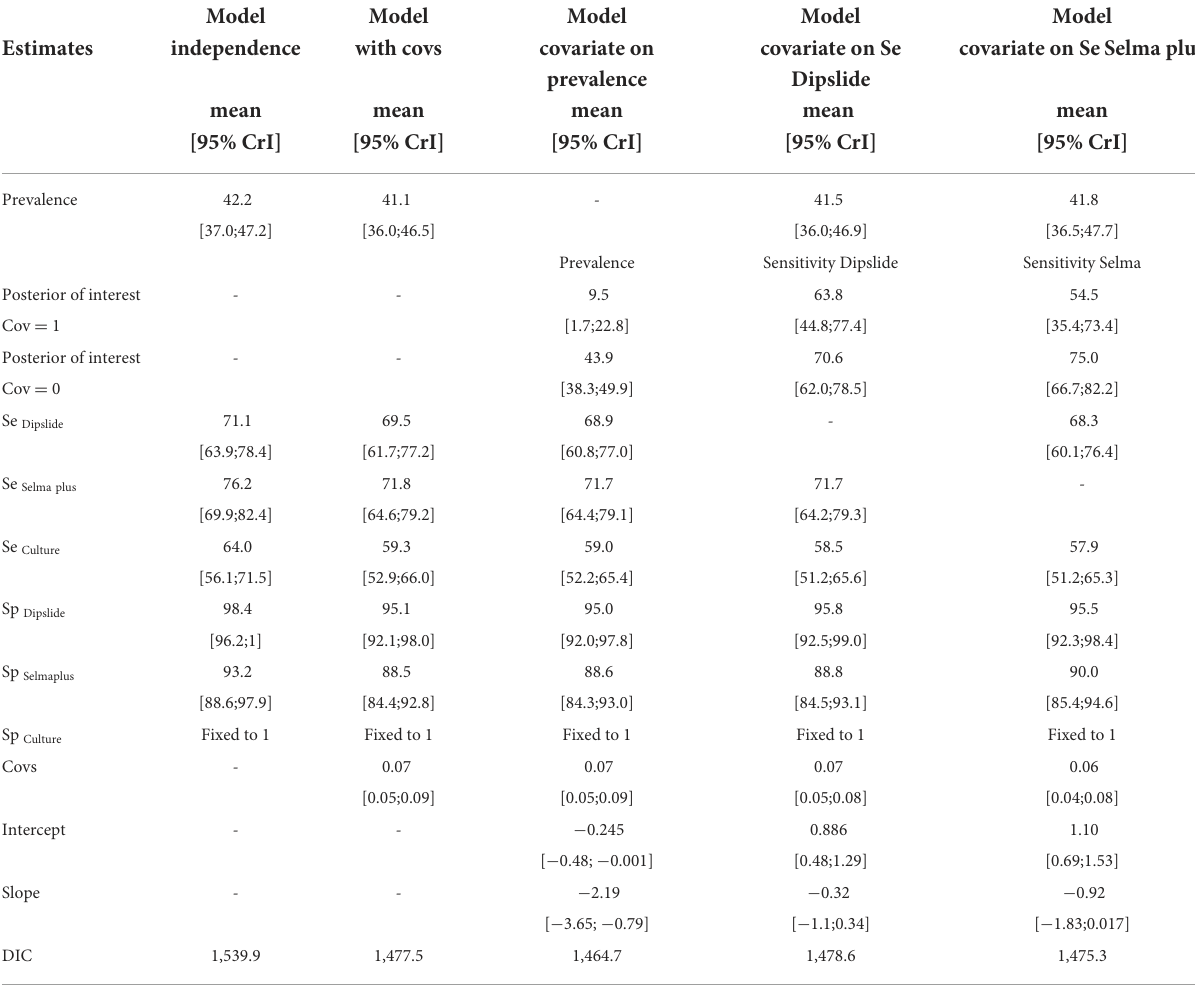
TABLE 2 Results of the final BLCMs for Streptococcus uberis encompassing three tests (Dipslide, Selma plus, and whole milk culture) in one population, to estimate diagnostic test accuracies of all three diagnostic tests using 509 milk samples collected from Swiss dairy cows suffering from clinical or subclinical